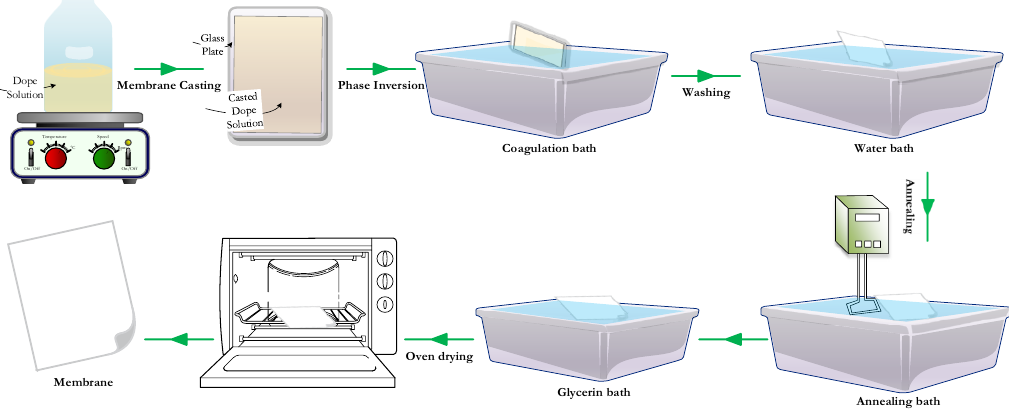
Figure 1. Schematic diagram of flat sheet membrane fabrication process through NIPS. Table 2. Summary of condition for flat sheet membrane fabrication through